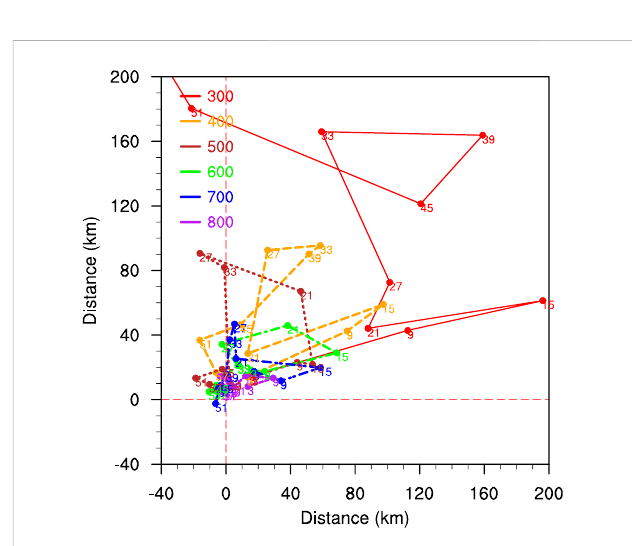
Position of the vortex center at 8 km relative to the vortex center at 2 km in EXP300, EXP400, EXP500, EXP600, EXP700, and EXP800. The numbers indicate the simulation time, and the relative positions are labeled every 6